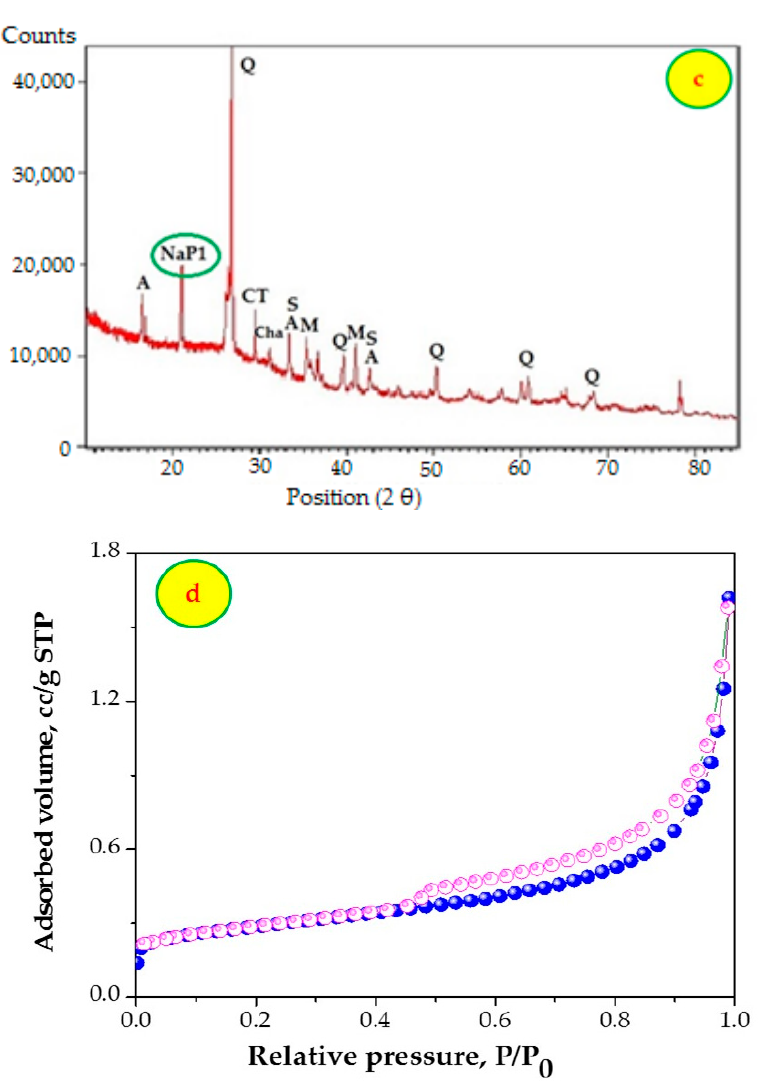
Figure 1. Characterization of the adsorbent: ( a ) SEM analysis; ( b ) FTIR analysis; ( c ) XRD analysis; ( d ) BET analysis.